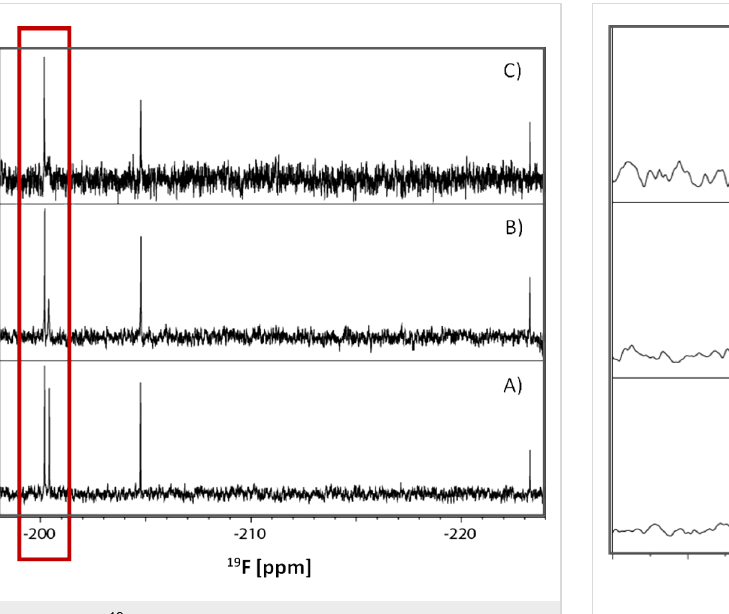
Figure 3: 1-D 19 F NMR: Experimental demonstration of differential binding of gluco- and manno-type 2-F-labeled maltose (2 mM) in the free form (A); bound to maltose-binding protein (200 µM) (B); and bound to MBP-V53 fusion protein (200 µM) (C). Highlighted area shows the gluco-type region. Spectra were recorded on a Bruker Avance DRX 600 MHz spectrometer by using a conventional 1-D pulse sequence. Up to 512 scans were acquired without signal suppression via T2 relaxation filter.